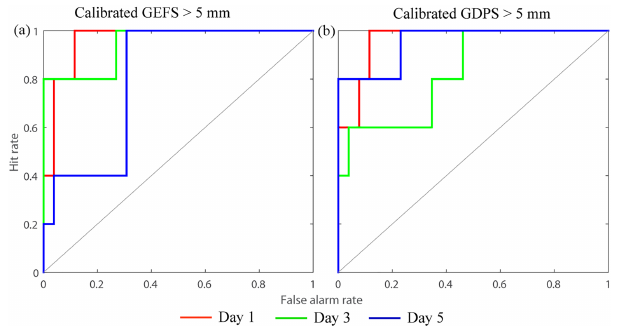
Figure 8. Relative operating characteristic (ROC) curves at lead times of 1, 3, and 5 days for calibrated QPFs for precipitation events greater than 5mm for subcatchment 11 during 10 June to 10 July 2013, with (a) and (b) showing ROC curves of calibrated GEFS and GDPS,